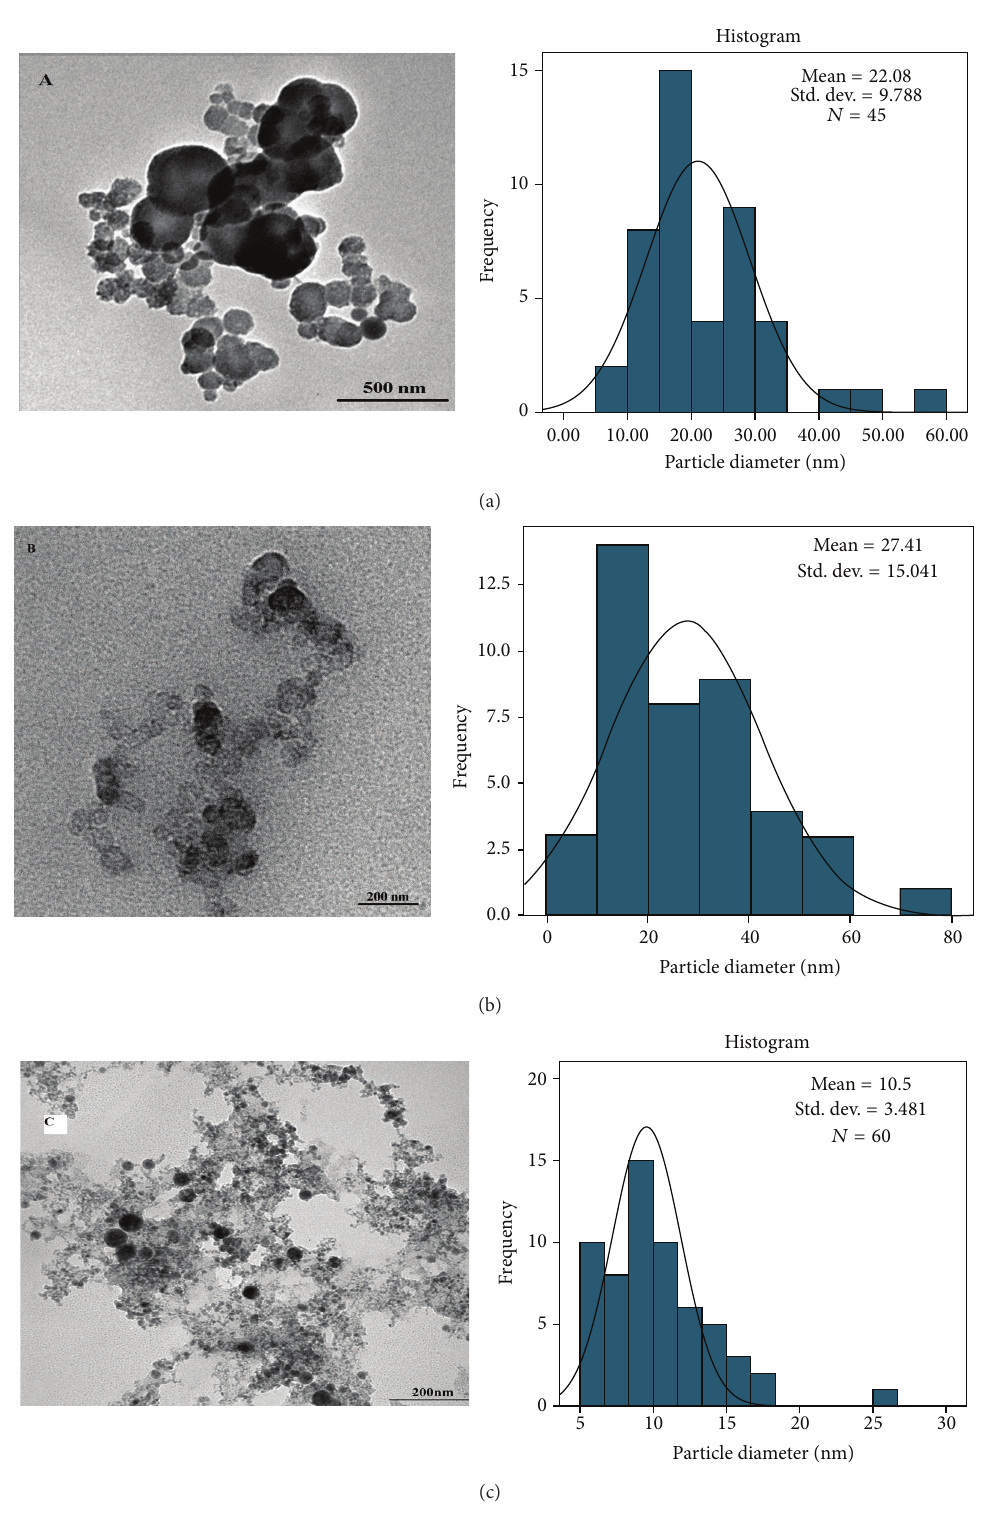
Figure 4: TEM image and typical of statistical graph for Ag-NPs produced in (a) EG, (b) in DW, and (c) in chitosan under 30 min ablation times in temperature